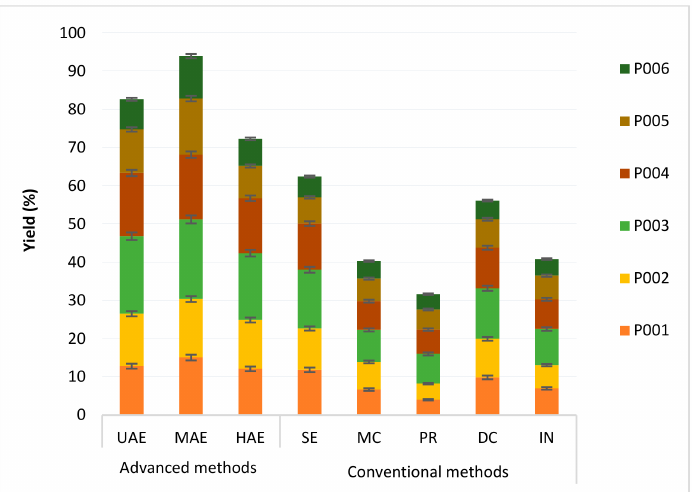
Figure 1. Extraction yields in the studied MAPs with advanced extraction techniques (microwave-, ultrasonic-, and homogenizer-assisted extractions) and conventional techniques (maceration, percola- tion, decoction, infusion, and Soxhlet). (P001) Corrigiola litoralis (L.), (P002) Tamarix aphylla (L. H.), (P003) Pistacia lentiscus (L.), (P004) Cyperus rotundus (L.), (P005) Nardostachys jatamansi (D. Don, DC.), and (P006) Lavandula coronopifolia Poir.